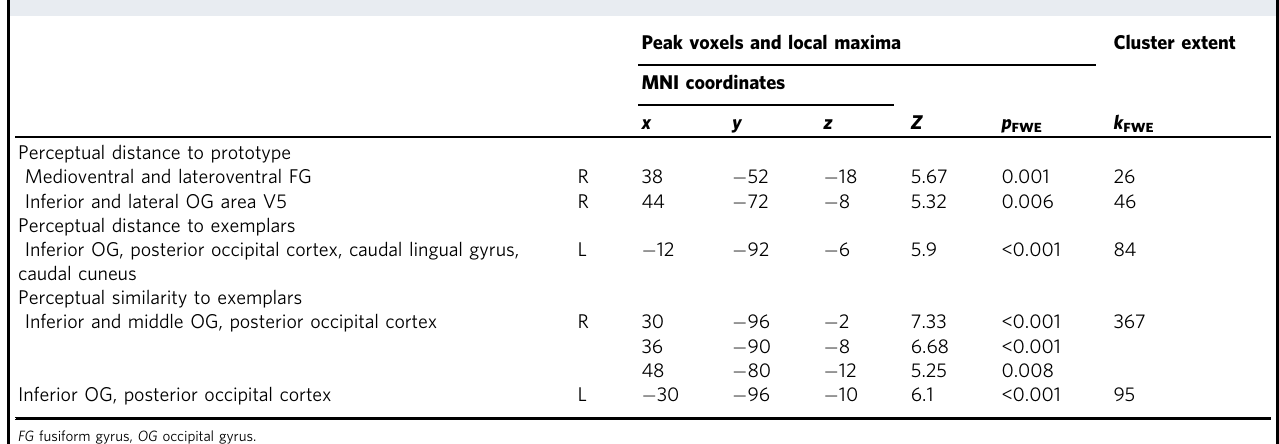
Table 1 Localisation of univariate prototype and exemplar